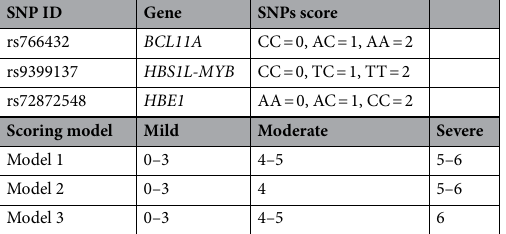
Table 5. Predictive SNP scoring system for β 0 -thalassemia/HbE disease severity.